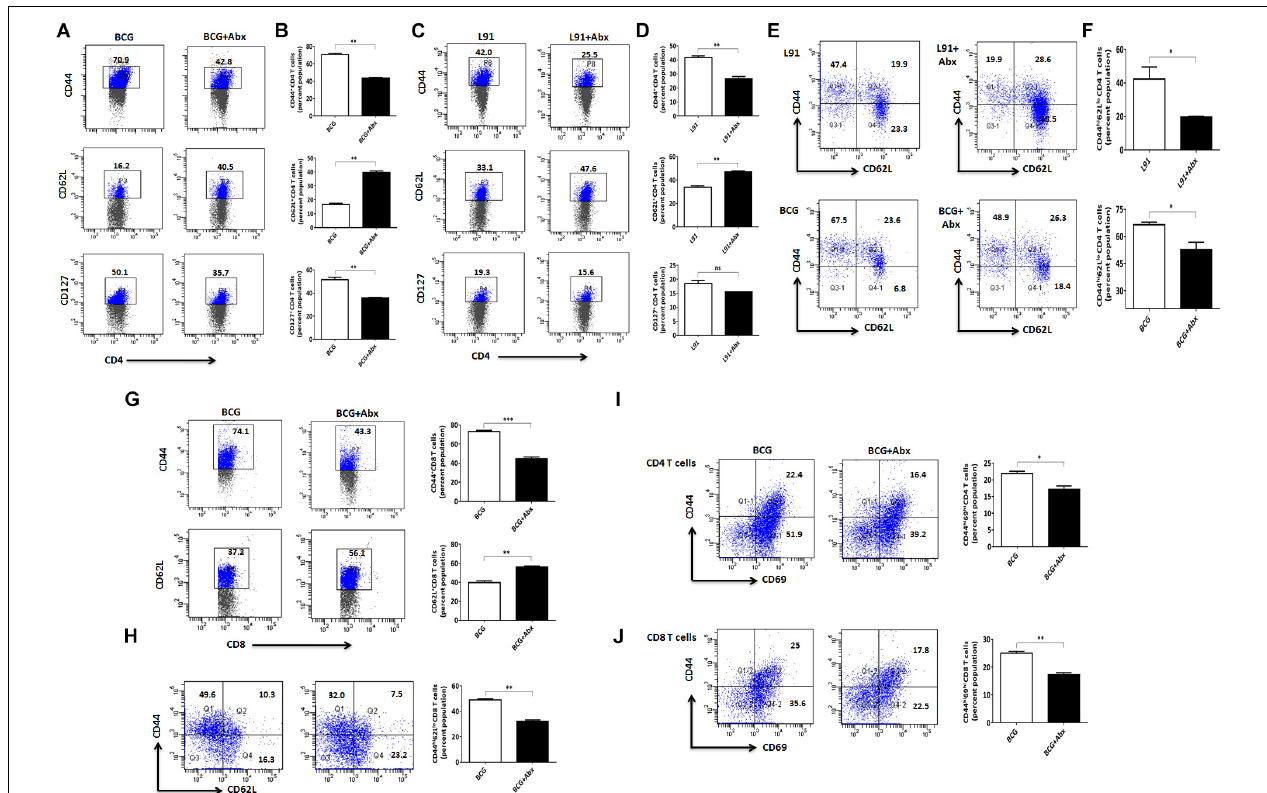
FIGURE 3 | Abx mediated gut dysbiosis impaired the activation and generation of memory T cells in lungs. The cells isolated from the lungs of Abx BCG or Abx L91 vaccinated mice were cultured and in- vitro stimulated with PPD for 48 h. After 48 h, the cells were harvested, stained and gated on (A–F,I) CD4 + T cell; (G,H,J) CD8 + T cells and assessed for the (A–D) activation markers CD44, CD62L, CD127, and CD69; (E,F) effector memory CD44 hi CD62L lo (T EM ) and (I–J) Resident memory CD44 hi CD69 hi (T RM ). Values in the inset and bar graphs signify percent population. Data shown as mean ± SEM are representative of two independent experiments ( n = 3–4 animals per group). * p < 0.05, ** p < 0.01, *** p <